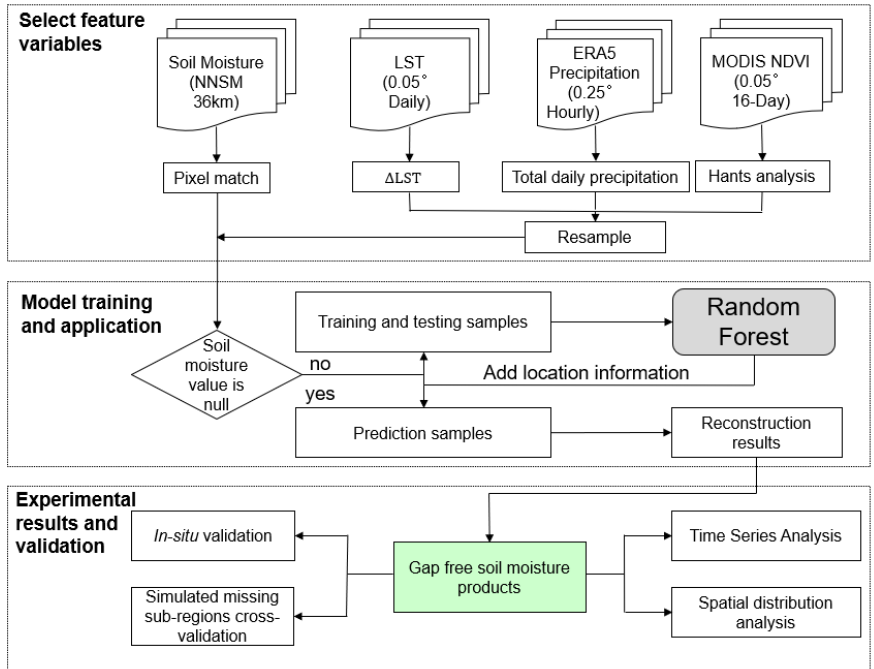
Figure 1. The workflow of data reconstruction by the pixel-wise RF method.